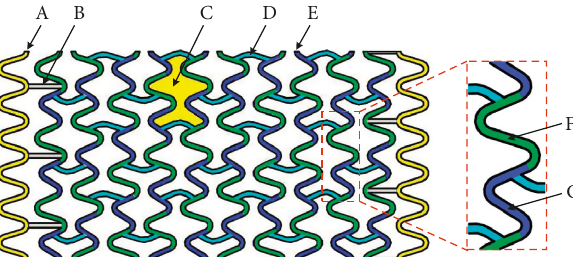
Figure 6: 2D schematic of the OCS. (A) equal-height supporting ring; (B) straight rod-shaped bridge; (C) open cell (D) c-shaped bridge; (E) unequal-height supporting ring; (F) small supporting element; (G) big supporting element.